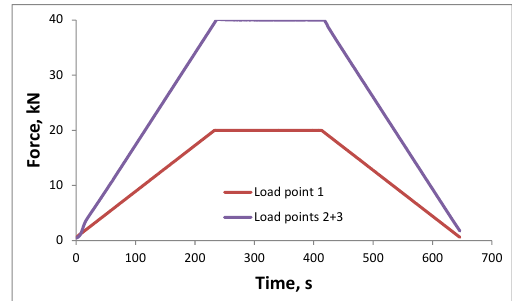
Fig. 16. Load-time recordings for load-unload test to 60 kN (20 kN per load point) Fig. 18. Example of correlation between FE prediction of axial strains along blade and measured values from strain gages and optical fibre, plotted versus distance from blade tip, for an applied load of 60 kN.(20 kN at each loading